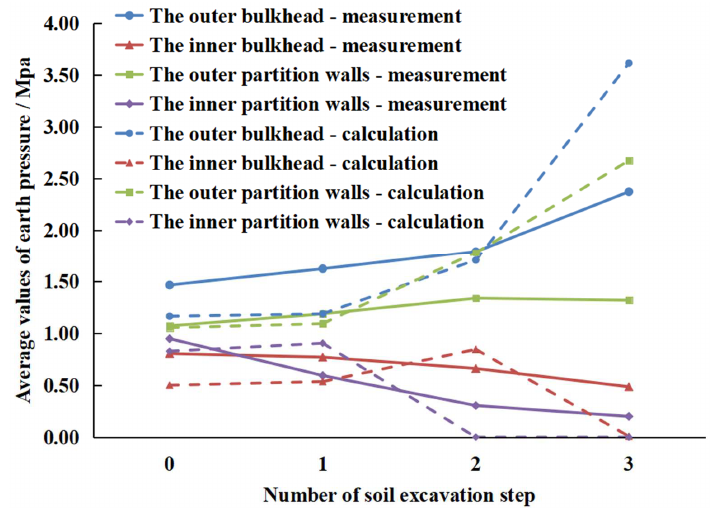
Figure 20. Comparison of earth pressure with soil excavation step. According to the time-history curve of end resistance with soil excavation process, the end resistance of inner bulkhead and inner partition wall gradually decreased with soil excavation procedure in the inner compartment, while it gradually increased in the outer areas, and the end resistance was transferred from the inner areas to outer areas. Furthermore, in the process of soil excavation in the outer compartment, it decreased in the outer partition wall. However, it continued to increase in the outer bulkhead, which